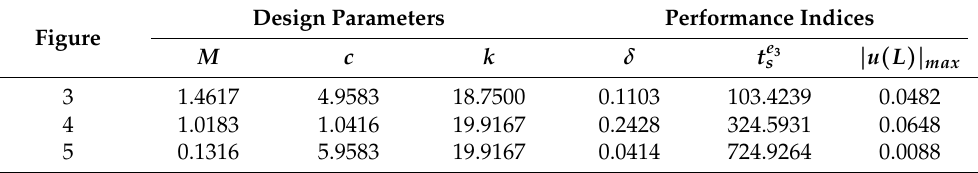
Table 3. Design parameters and performance indices of optimal designs in Figures 3–5. Design Parameters Performance Indices Figure M c k δ t e 3